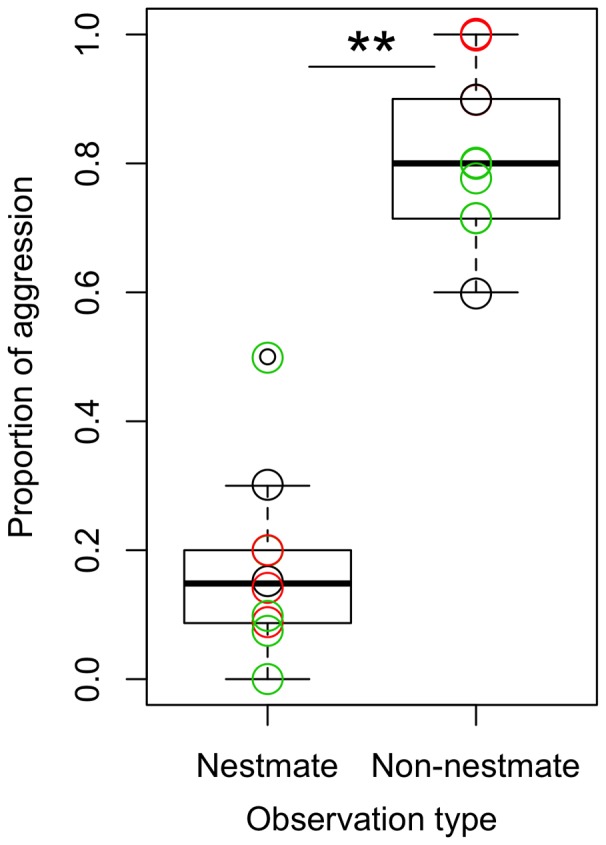
Proportion of aggressive behavior by Cr. levior in behavioral assays with nestmate and non-nestmate Cr. levior ants.The boxplot shows the mean +/− standard deviation. Black circles are for colony pairs considered within Cr. levior Type A combinations (n = 2), green circles are for within Cr. levior Type B combinations (n = 5), and red circles are for between Cr. levior Type A and Cr. levior Type B combinations (n = 3). The asterisks indicates there was significantly more aggression to non-nestmates (p<0.05).